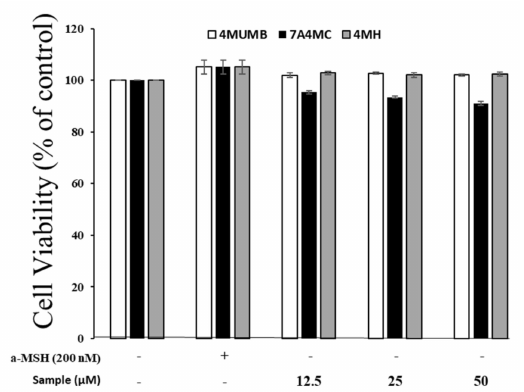
Figure 2. Cell viability of 4MUMB, 7A4MC, and 4MH-treated B16F10 mouse cells with ( + ) or without (-) α -MSH. The cells were supplemented with di ff erent concentrations (12.5, 25, and 50 µ M) of 4MUMB, 7A4MC, and 4MH for 72 h and the proliferation of the cells was assessed.